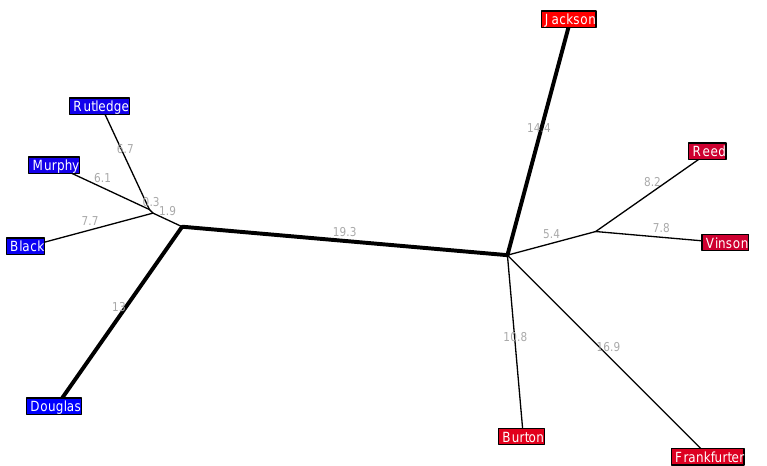
Figure 11. Judicial tree for the 1946–1949 Vinson 1